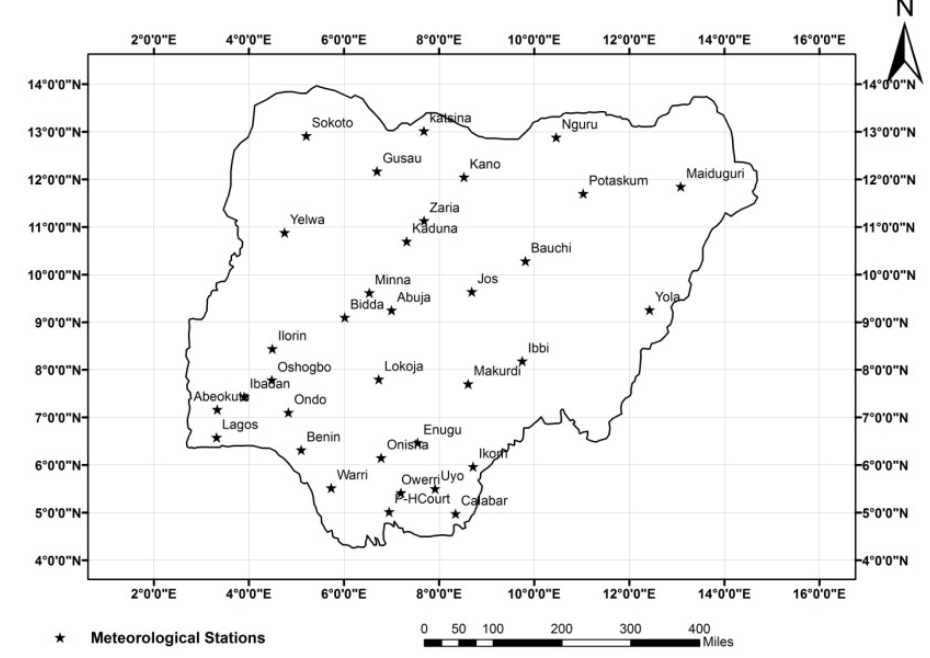
Figure 1. The distribution of meteorological stations over the study